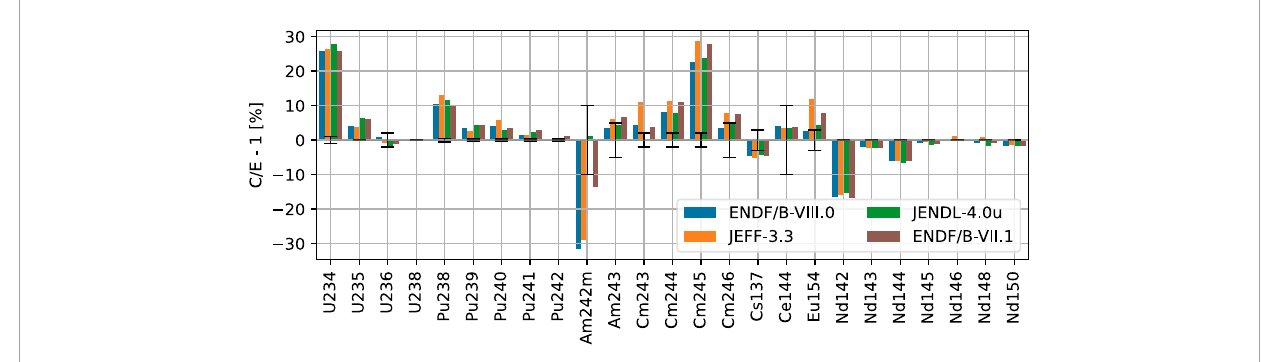
burnup discrepancy. The sample burnup discrepancy amounts to about 3% and is consistent with that reported in Grimaldi et